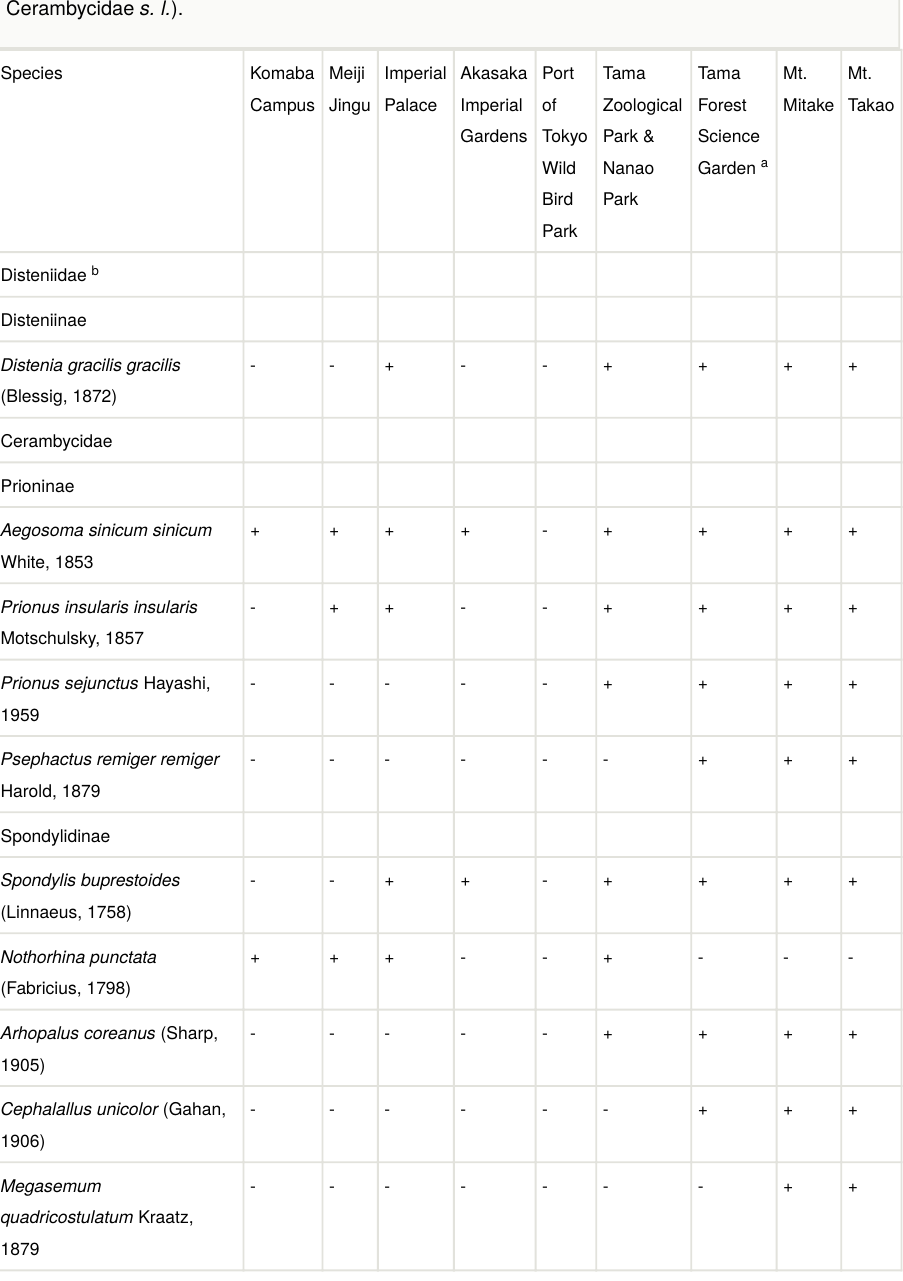
Table 2. Species list of the study site and eight reference locations. See references of the data on the presence (+) or absence (-) of species in Table 1. a) Tama Forest Science Garden of Forestry and Forest Products Institute. b) The family Disteniidae is a group within longhorn beetles (i.e. Cerambycidae s.